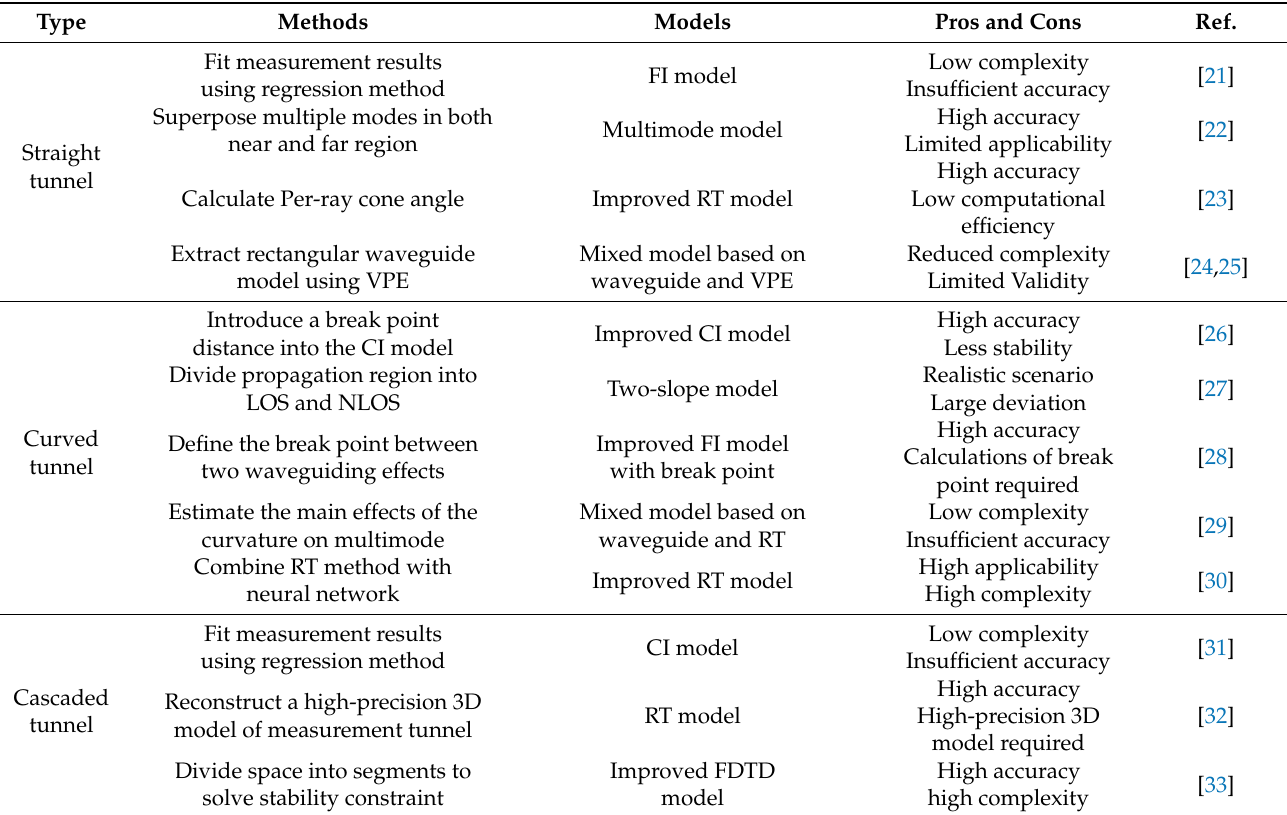
Table 1. State-of-the-art related works on path-loss models in tunnel environments. Models Pros and Cons